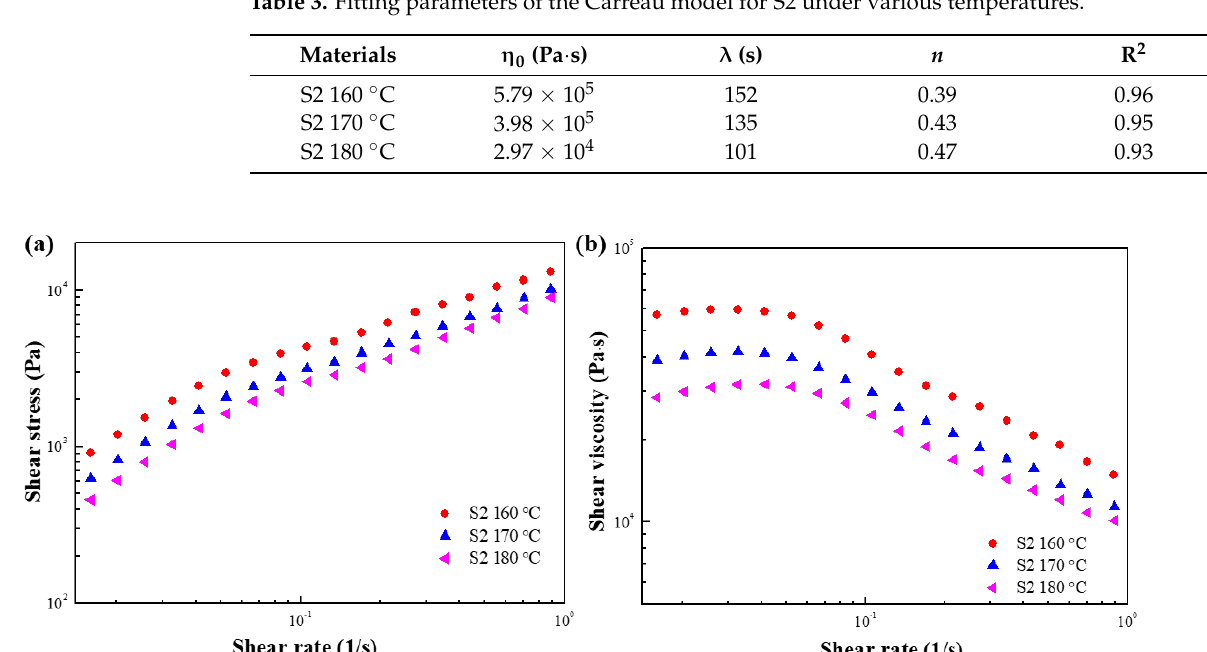
Figure 9. ( a ) Shear stress and ( b ) shear viscosity as a function of shear rate for S2 at various temper- atures.